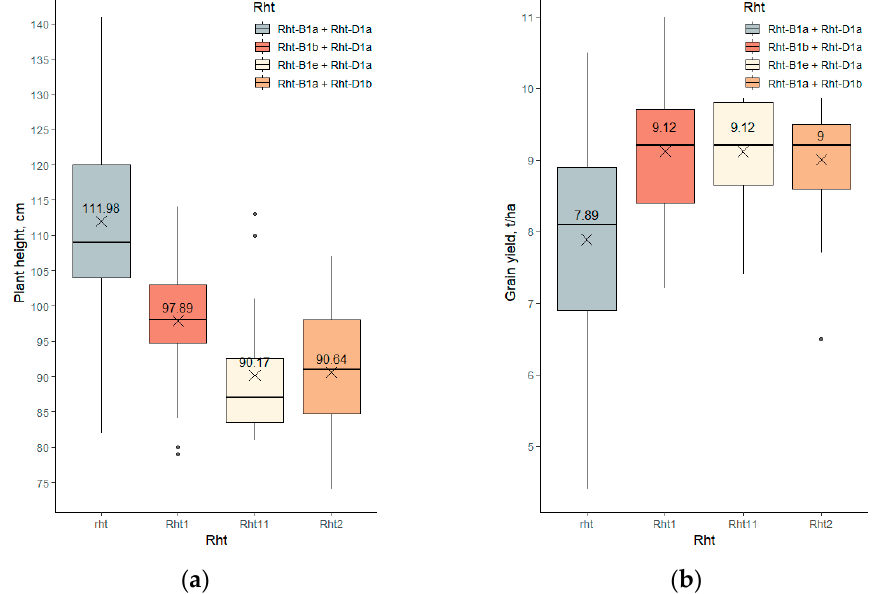
Figure 2. Plant height ( a ) and grain yield ( b ) BLUEs of accessions possessing different alleles of gibberellin-insensitive dwarfing genes in winter bread wheat collection. Here and further on box- plots: the lower and upper boundaries of boxes indicate the first ( 𝑄1 ) and the third ( 𝑄3 ) quartile; the horizontal lines in each box designate the medians; the crosses with the numbers below designate the observed means; the vertical line tips designate the minimum and maximum values within the interval [𝑄1 − 1.5(𝑄3 − 𝑄1), 𝑄3 + 1.5(𝑄3 − 𝑄1)] ; the dots indicate outliers.